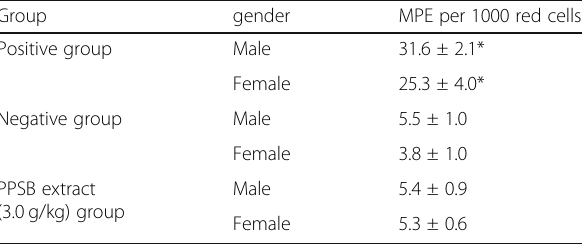
Table 3 Number of micronucleated polychromatic